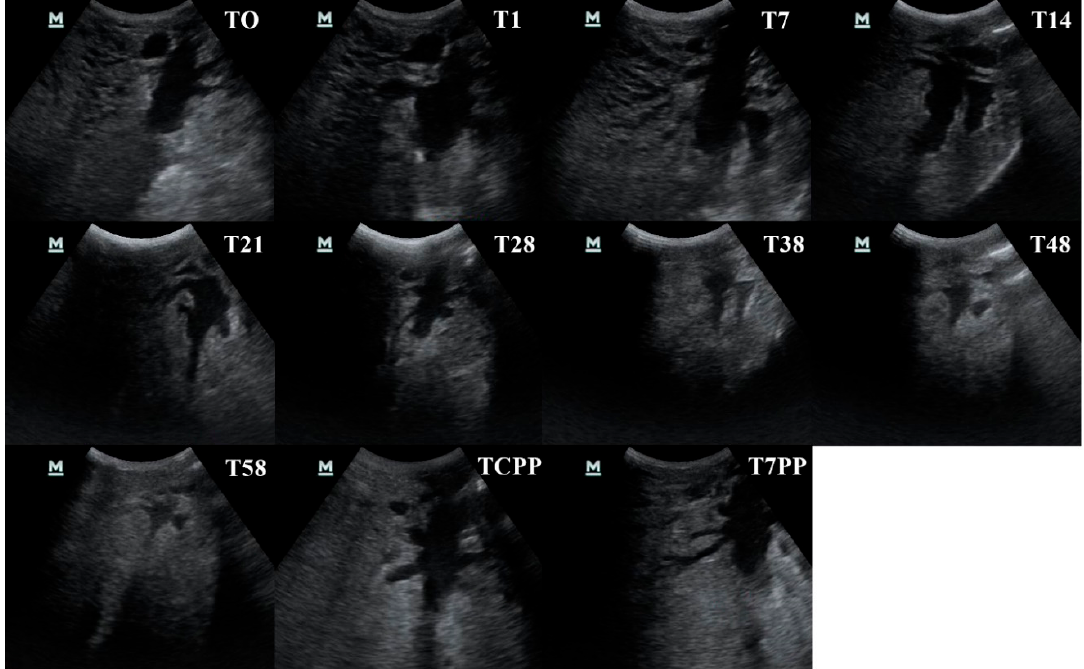
Figure 7. Scatter box plot showing the median, minimum and maximum values of the ultrasonographic udder cistern size between T0 vs. T58 vs. T colostrum production phase (TCPP) vs. T 7 days post-partum (T7PP) for the hind quarter cross section (HQCS). Legend: a ≠ b ≠ c ≠ d: p < 0.05.